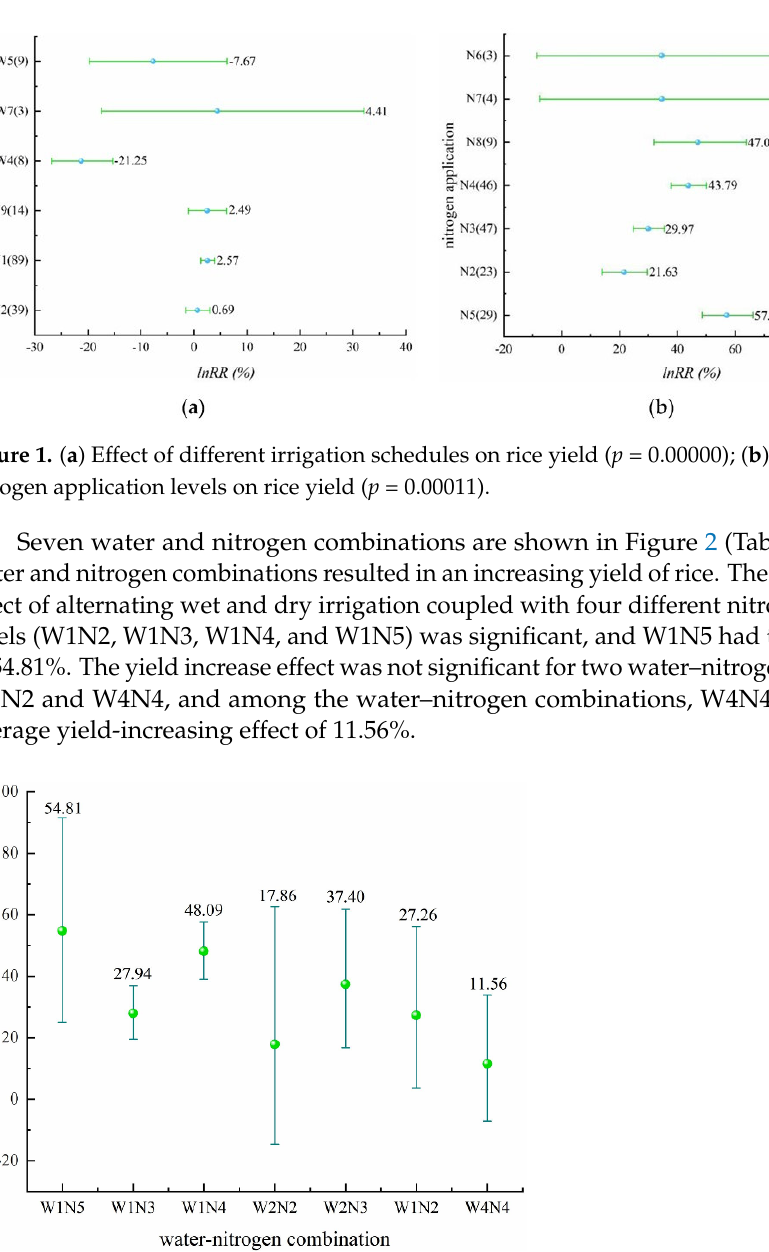
Figure 2. Effect of different water – nitrogen combinations on rice yield ( p = 0.00987).